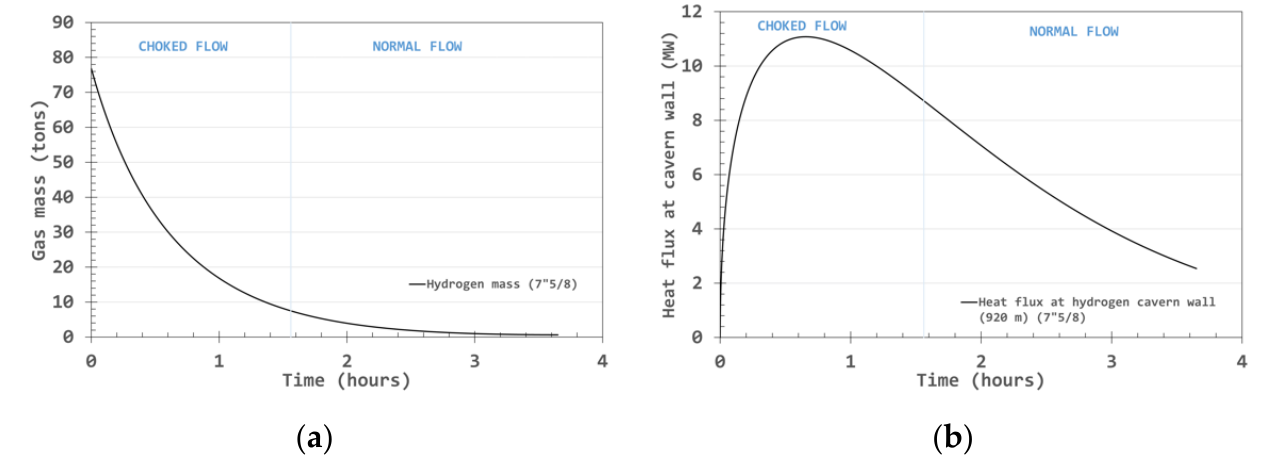
Figure 2. Evolution of: ( a ) Hydrogen mass; ( b ) heat flux, at the salt cavern wall as a function of time. The blowout lasts approximately 3.65 h in the EZ53 salt cavern. Hydrogen flow is choked (gas velocity is sonic at the wellhead) during the first 1.56 h and normal during the second half of the blowout. Figure 3 successively displays: (a) hydrogen pressure in the cavern and ground level, (b) hydrogen temperature in the cavern and outlet tempera- ture, (c) hydrogen density at cavern top and ground level, and (d) hydrogen velocity at cavern top and ground level.